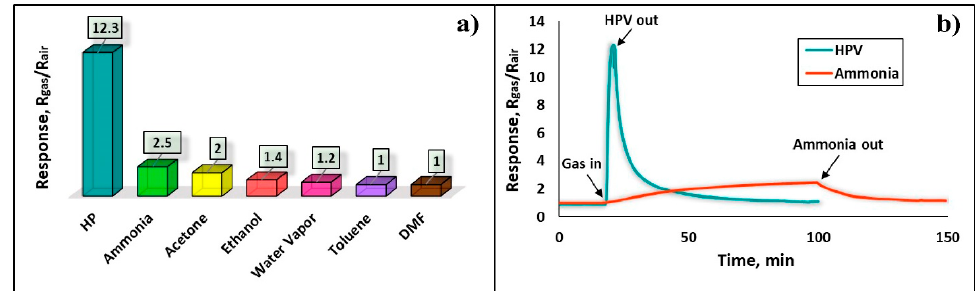
Figure 12. ( a ) Selectivity of the Fe 2 O 3 :ZnO sensor for HPV under UV irradiation at RT and ( b ) real- time response curves of the sensor to 1.5 ppm HPV and 130 ppm ammonia.